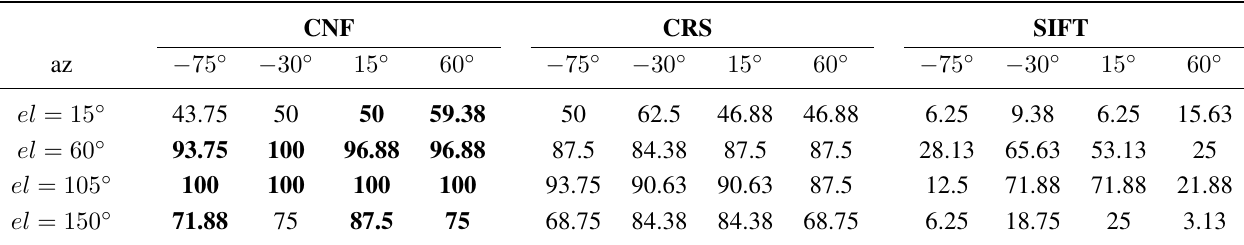
Table 1. Recognition rates on the query set when α = 0 . 5 and β = 0 . CNF, descriptor derived from the characteristic number; CRS, cross-ratio spectrum.